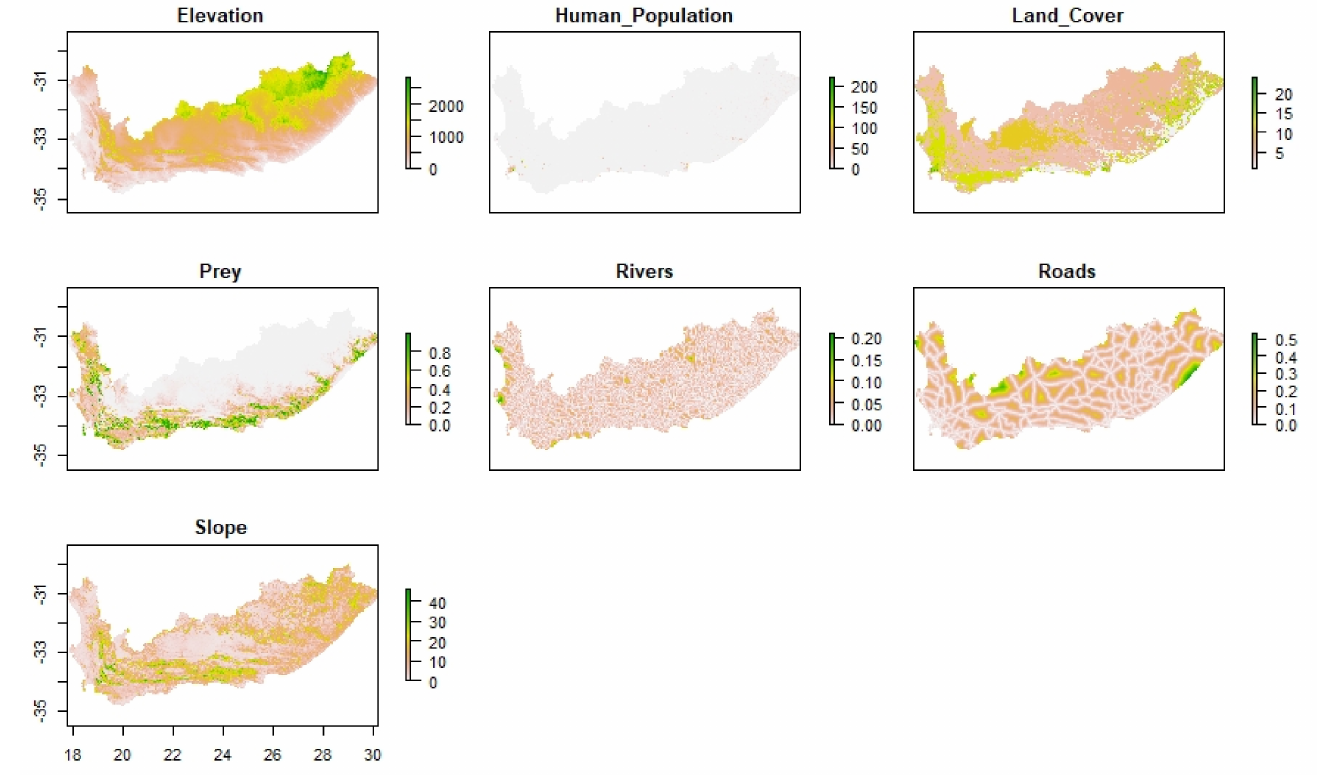
Figure 2. Environmental covariates used to predict leopard habitat